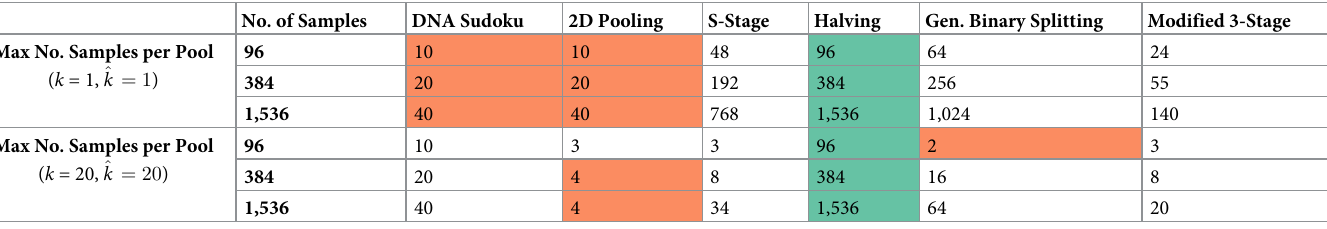
Table 4. Maximum number of samples per pool for each of the pooling methods for sample sizes N = 96, 384, and 1,536, when k = 1 and k = 20. No. of Samples DNA Sudoku 2D Pooling S-Stage Halving Gen. Binary Splitting Modified